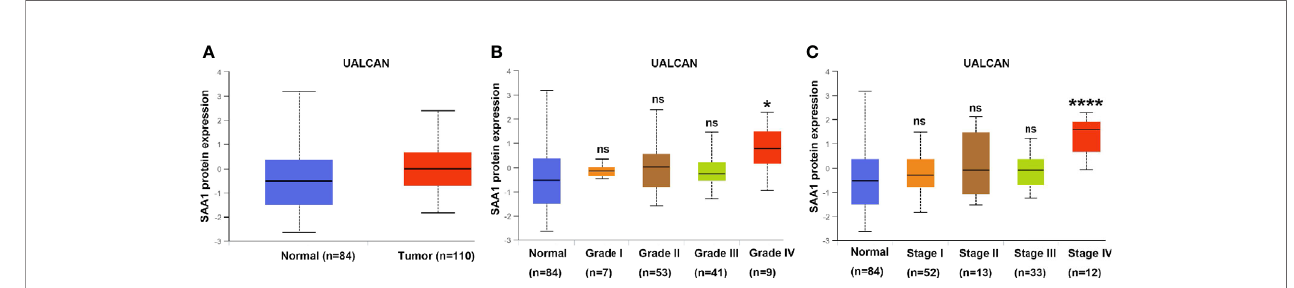
FIGURE 4 | Analysis of SAA1 protein expression using UALCAN database. (A) The protein expression analysis of SAA1 in ccRCC samples from UALCAN database. (B) The protein expression levels of SAA1 were compared in tumor grade from UALCAN database. (C) The protein expression levels of SAA1 were compared in